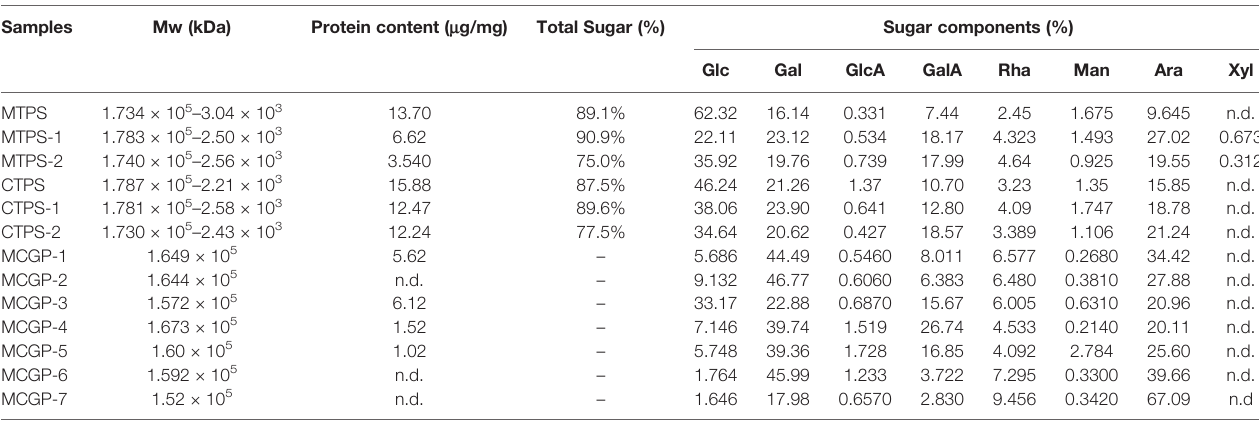
TABLE 1 | Monosaccharide composition of MCGP-1 – MCGP-7.